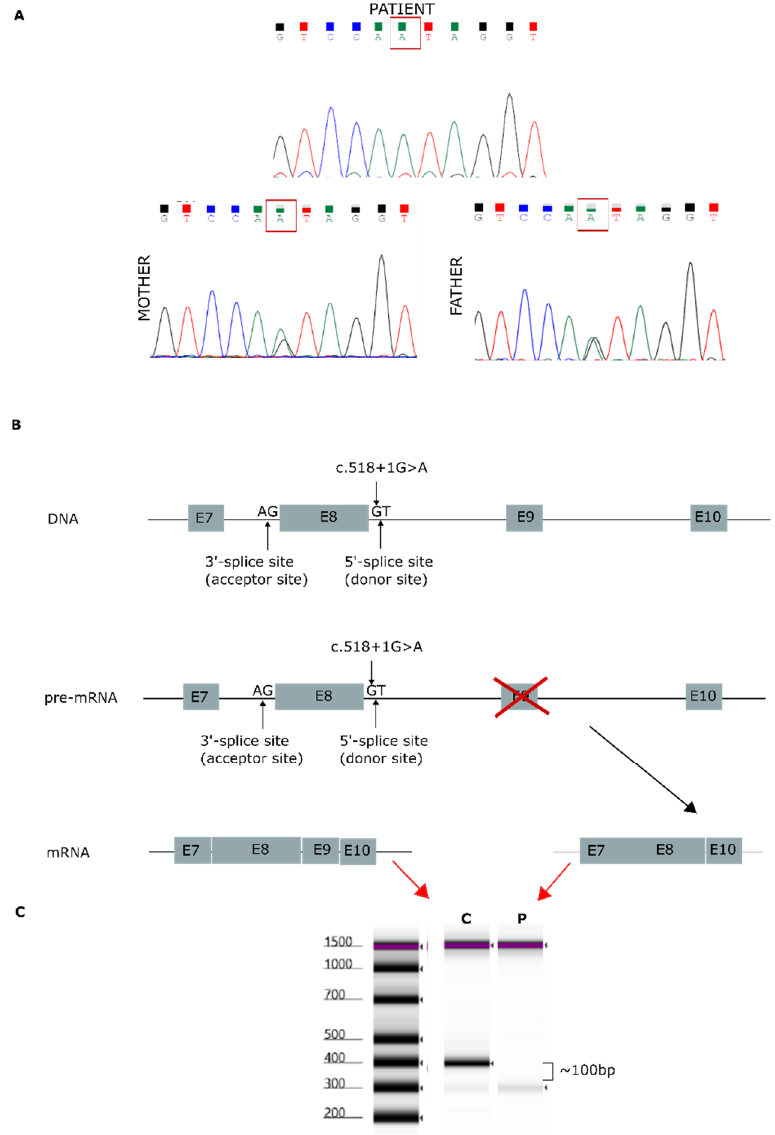
Figure 1. Genetic analysis findings. ( A ) Genomic DNA sequence chromatograms showing Sanger sequencing results. Both parents carried the splicing variant c.518+1G>A, located in intron 8. ( B ) AGK gene: predicted effect of exon 9 skipping during mature mRNA splicing. ( C ) cDNA sequencing of patient [P] and control [C], showing a 96-bp decrease in the length of the AGK cDNA sequence.